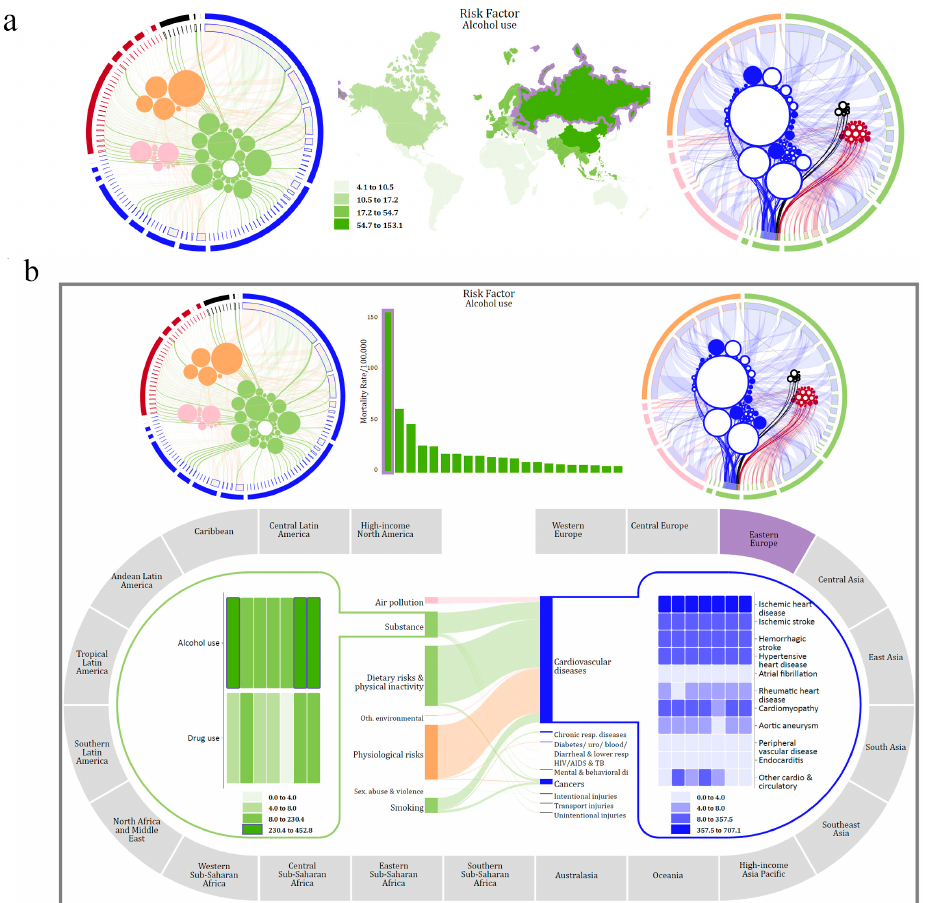
Figure 9. ( a ) Top portion of the geography visualization with a map in the center and alcohol use selected; ( b ) In the top portion, an alternative view (i.e., bar chart) has been chosen to better aid the task of comparison; in the bottom portion, Eastern Europe has been selected.